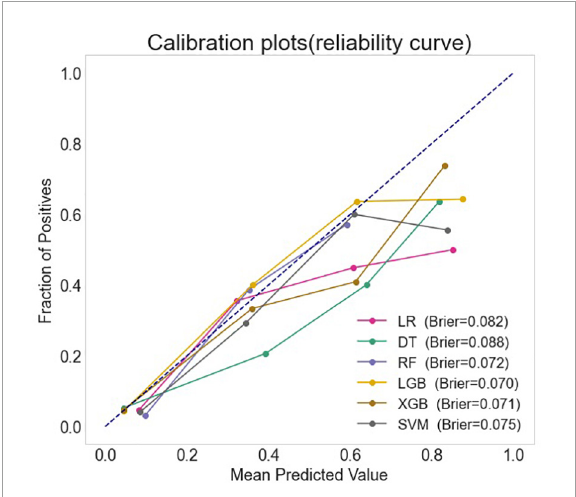
FIGURE2 The calibration curves and the Brier score of different machine learning models. LR, logistic regression; DT, decision tree; RF, random forest classifier; LGB, light gradient boosting machine; XGB, extreme gradient boosting machine; SVM, support vector